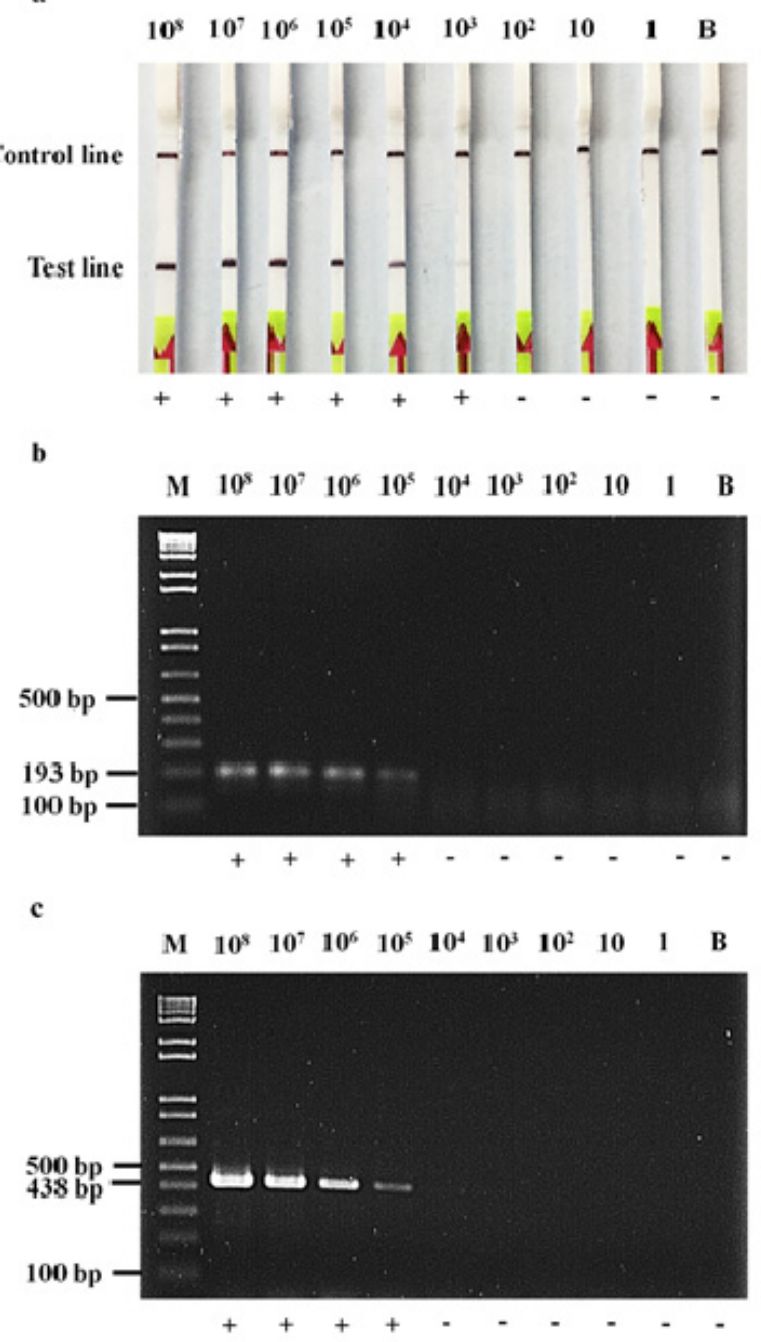
Figure 2. Comparison of the detection limit of the RPA-LF assay ( a ), with assays of the RPA-AGE ( b ), and the PCR-AGE ( c ), for detection of bla OXA-48-like . M, 1 kb plus DNA ladder; 1-9, 10-fold serial dilutions of K. pneumoniae isolates harboring bla OXA-48 ranging from 10 8 to 1 CFU/mL, respectively; and B, blank .